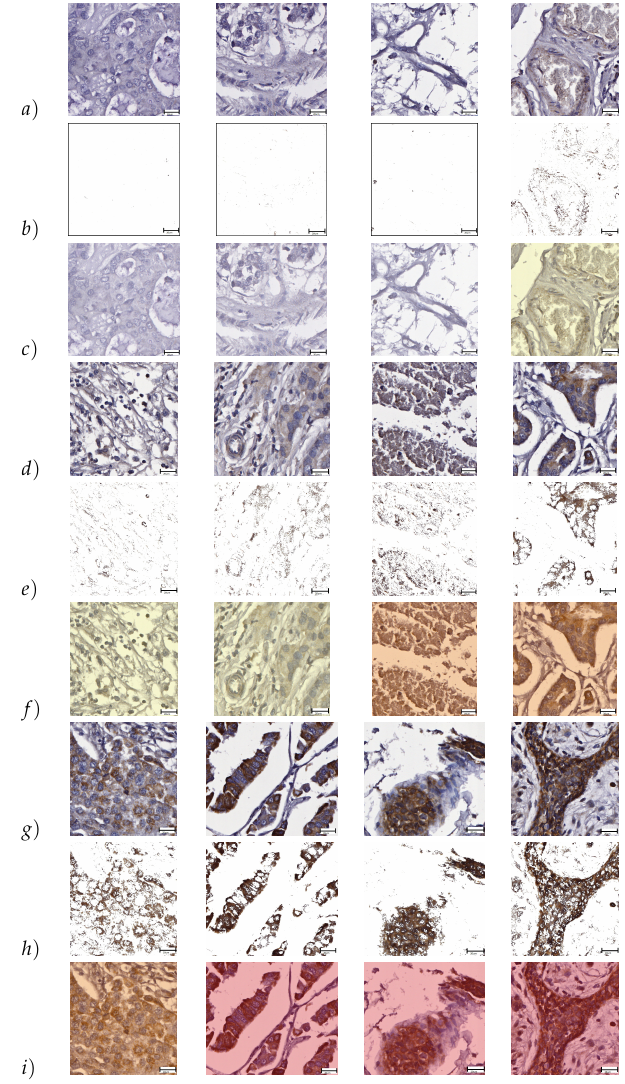
Figure 2. Selected Wnt-1 segmentation and classification results: ( a , d , g ) original image blocks are presented; ( b , e , h ) automatic segmentation using color convolution; and ( c , f , i ) automatic Allred score classification, scale bar = 20 µ